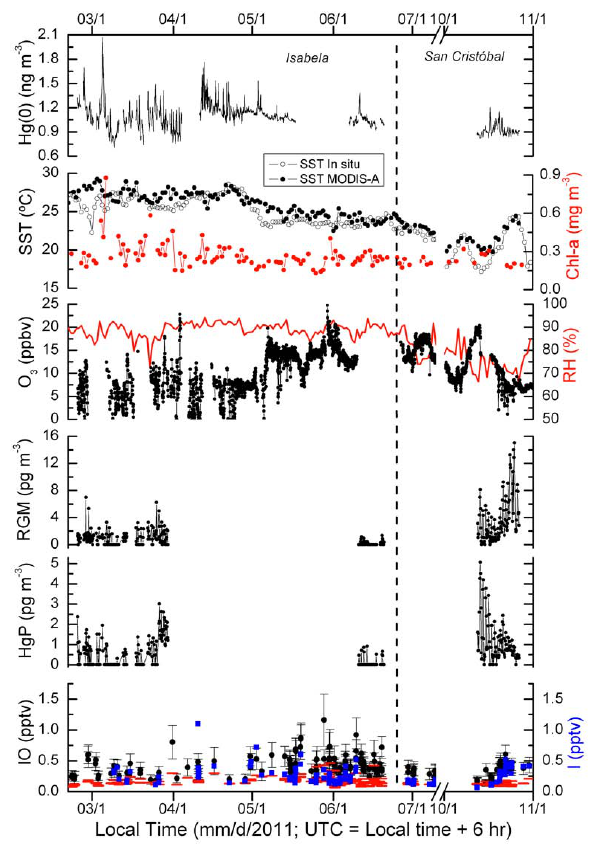
Fig. 2. Atmospheric mercury and related parameters over the Galá- pagos Islands. From top to bottom: atmospheric Hg(0) (hourly av- erage), sea surface temperature (SST; daily average) and ocean sur- face Chl a (daily average), atmospheric marine boundary layer O 3 (every 10min) and relative humidity (RH; daily average), reactive gaseous mercury (RGM) and particulate mercury (Hg P ; every 3h), and IO (every 1h; detection limit is shown in red) and I atom (calcu- lated from IO and O 3 ) over the entire study period. The data before 1 July 2011 were obtained at Puerto Villamil on Isabela Island, and those after were from Puerto Baquerizo Moreno on San Cristóbal Island.